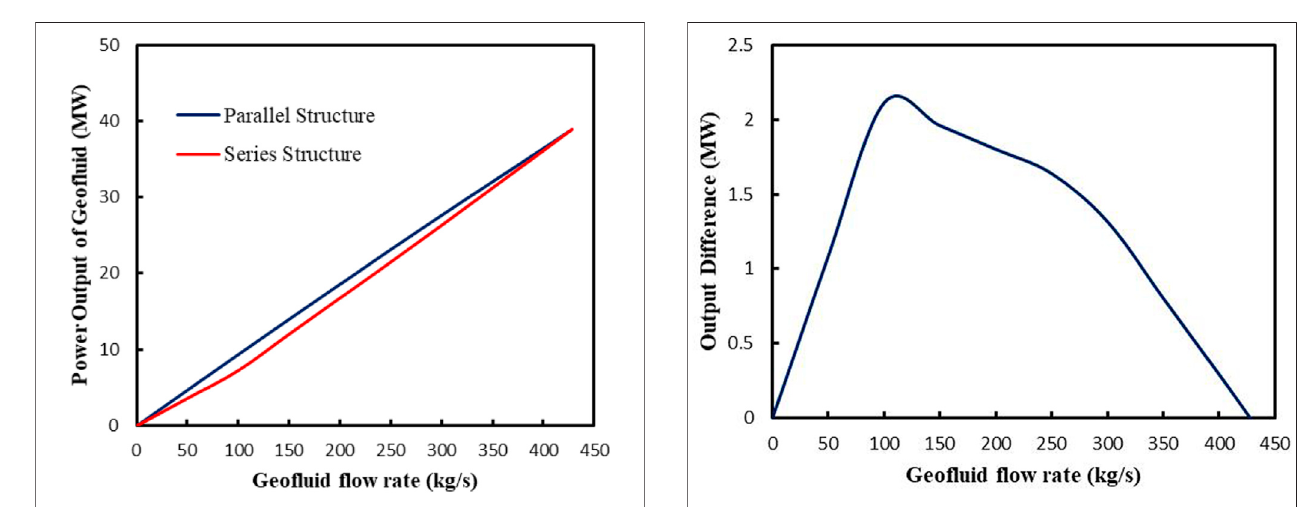
FIGURE 8 | The power output of geothermal energy of two kinds of GAPG plants with different geothermal fl uid integration.